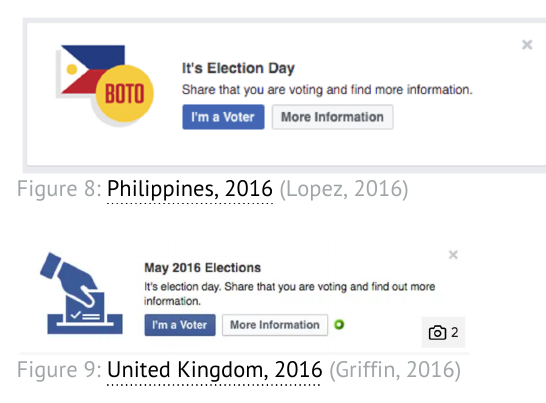
Figure 7: Israel, 2015 (Kenan, 2015)